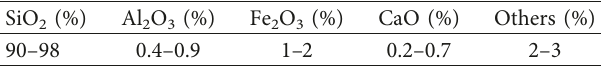
Table 2: Chemical compositions of microsilica.